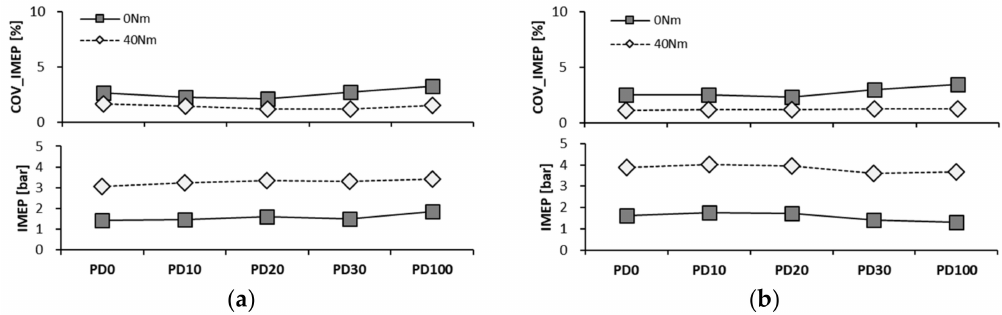
Figure 6. COV of IMEP and IMEP by pilot timings: ( a ) pilot BTDC 20 ◦ CA, main BTDC 2 ◦ CA, ( b ) pilot BTDC 15 ◦ CA, main BTDC 2 ◦ CA.